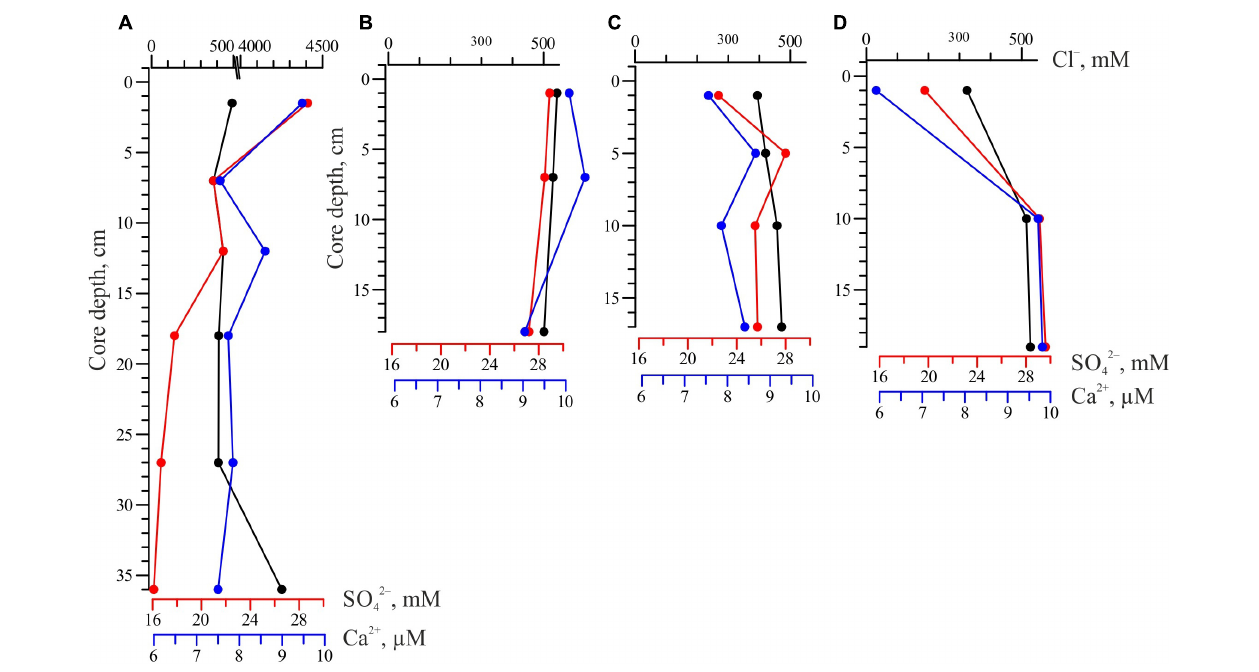
FIGURE 3 | Sediment pore water profiles for chloride (Cl − , mM), sulfate (SO 2 − 4 , mM) and calcium (Ca 2 + , µ M) from the background sediments of the Laptev Sea: (A) st. 5218, depth 18 m, 72 ◦ 41.0 (cid:48) N, 130 ◦ 30.0 (cid:48) E; (B) st. 5224, depth 60 m, 77 ◦ 06.1 (cid:48) N, 130 ◦ 29.3 (cid:48) E; (C) st. 5225, depth 2,700 m, 78 ◦ 22.0 (cid:48) N, 130 ◦ 30.0 (cid:48) E; (D) st. 5227, depth 1,980 m, 78 ◦ 05.5 (cid:48) N, 130 ◦ 30.6 (cid:48) E. For station location see Figure 1